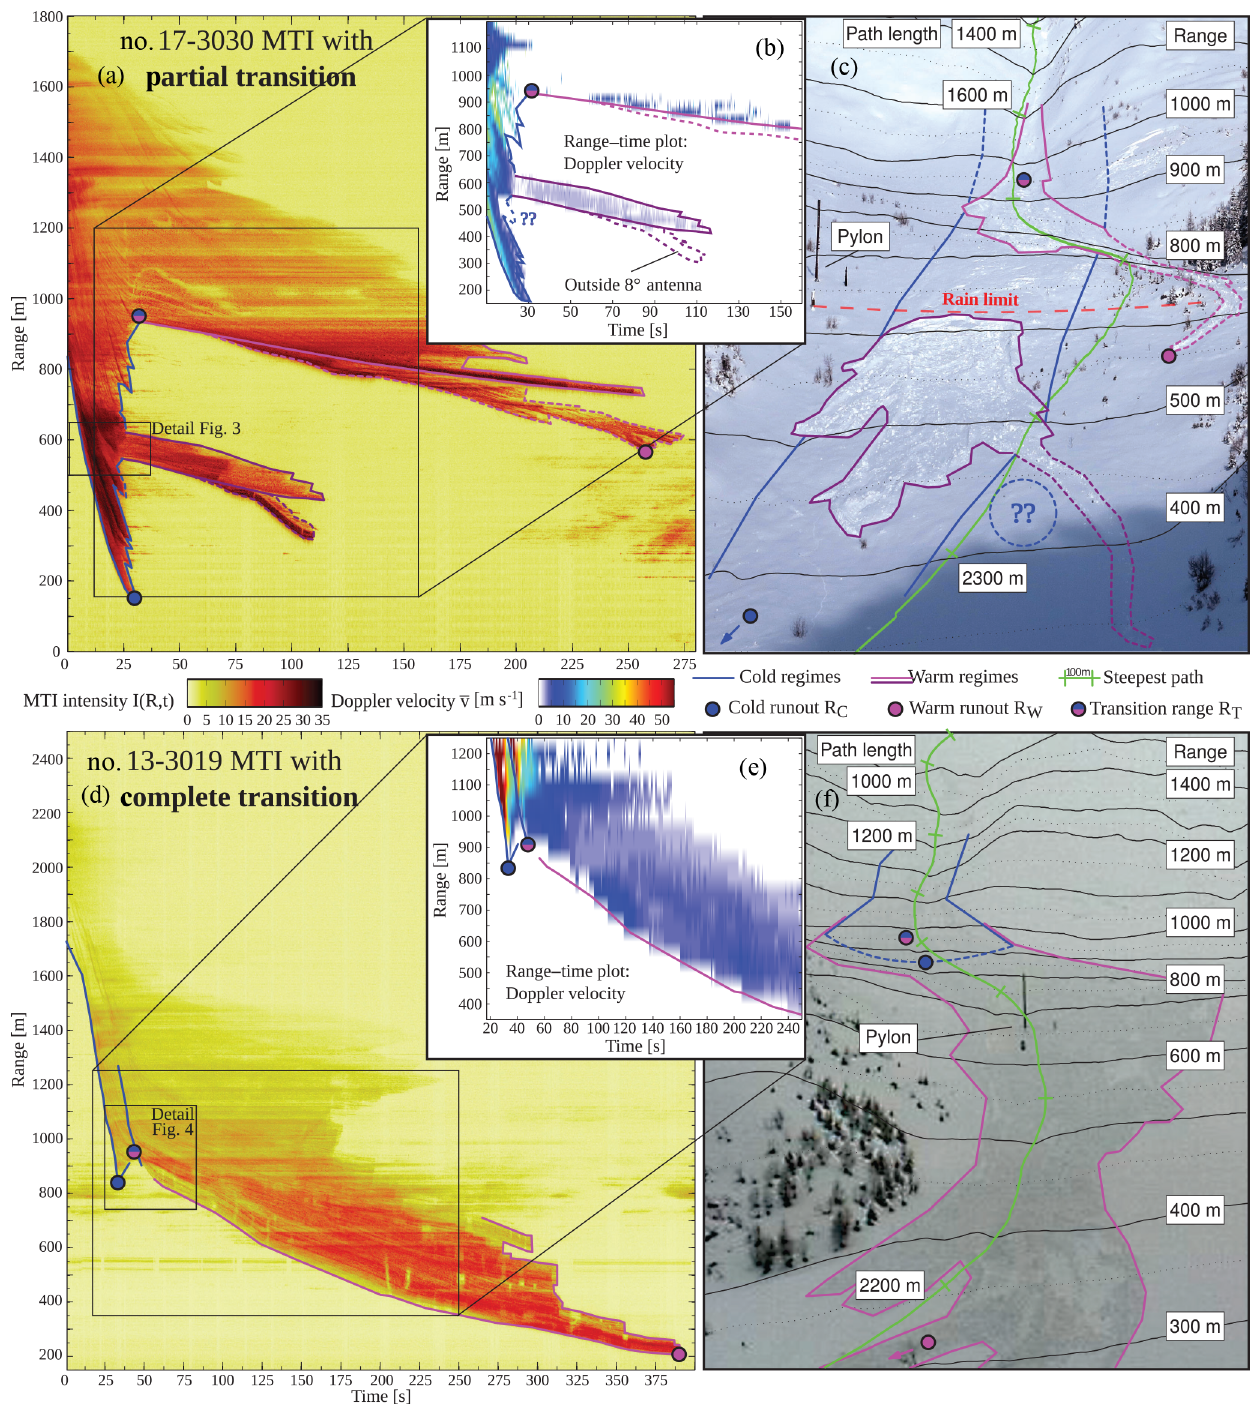
Figure 2. Avalanche examples for a partial (top, a–c ) and a complete (bottom, d–f ) cold-to-warm transition. The avalanches are visualized by means of GEODAR data (a, d) , mean Doppler velocities v k (t) (b, e) and geo-referenced pictures of the deposits (c, f) . Flow features extracted from GEODAR are highlighted in the other panels. The warm regimes are identified by typical coarse-grained and rough deposits (purple and magenta), while the fine-grained and smooth cold deposits can only be sketched (blue). The path along the steepest descent is drawn in green. The cold and warm runout distances and the transition point are indicated with coloured